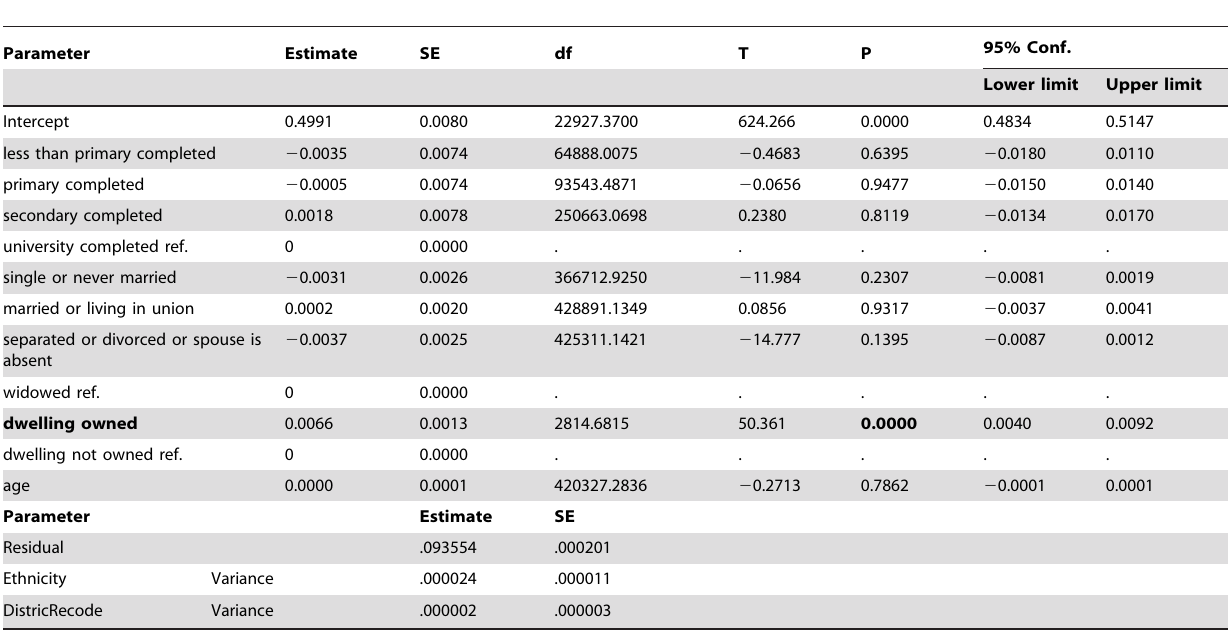
Table 2. LMM of age, marital status, education and ownership of dwelling (ethnicity and Uganda district as random factors) is regressed on